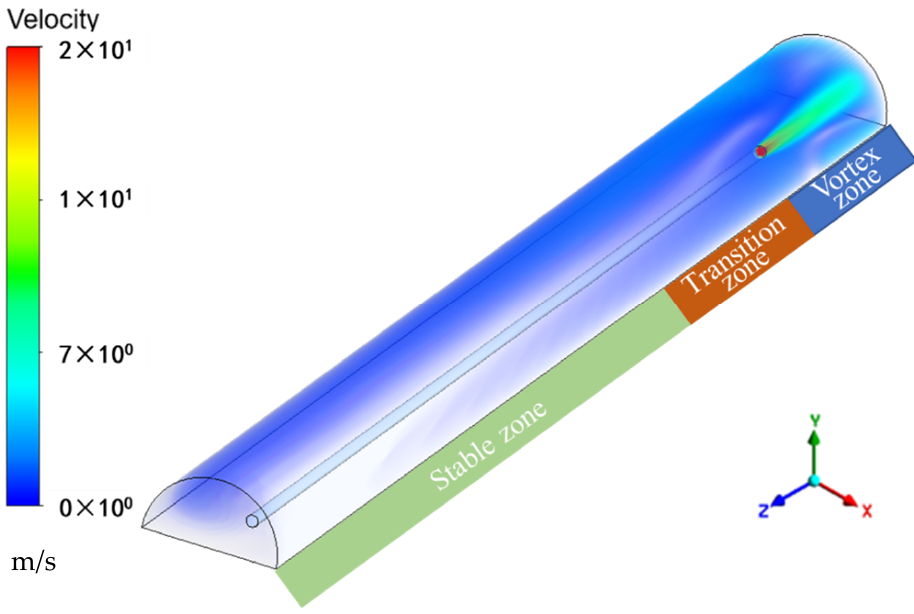
Figure 2. Distribution of airflow streamlines in the tunnel.